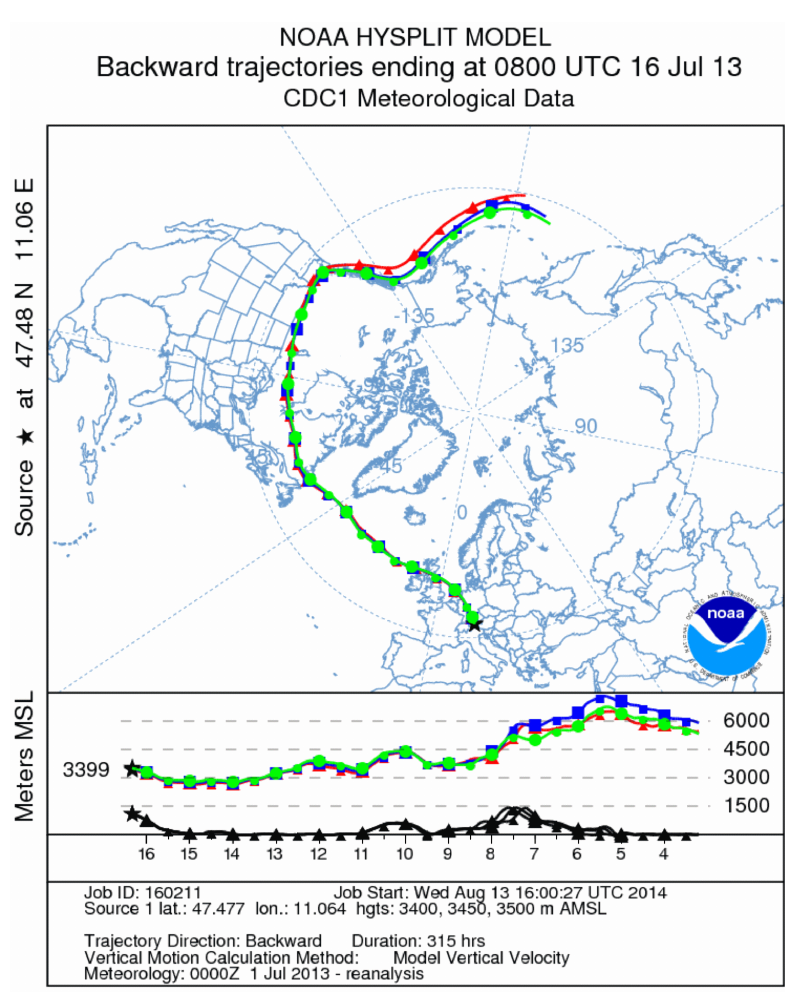
Figure 17. HYSPLIT backward trajectories calculated for altitudes of 3400, 3500 and 3600ma.s.l. over Garmisch-Partenkirchen showing almost steady subsidence from the North Pacific within 315h. AMSL: above mean sea level. The black line in the altitude box shows the ground